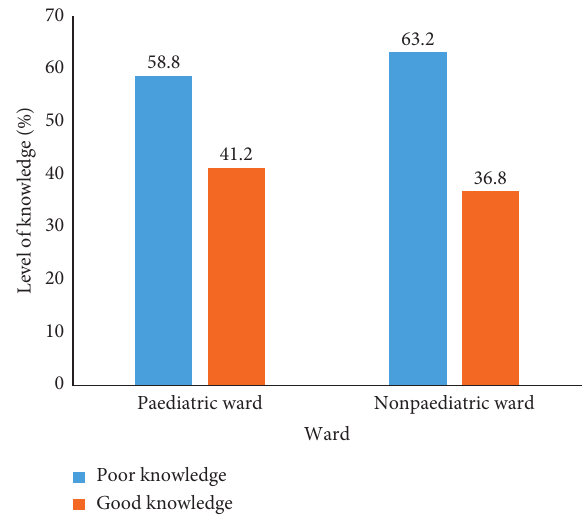
Figure 2: Overall level of knowledge on paediatric pain management according to ward